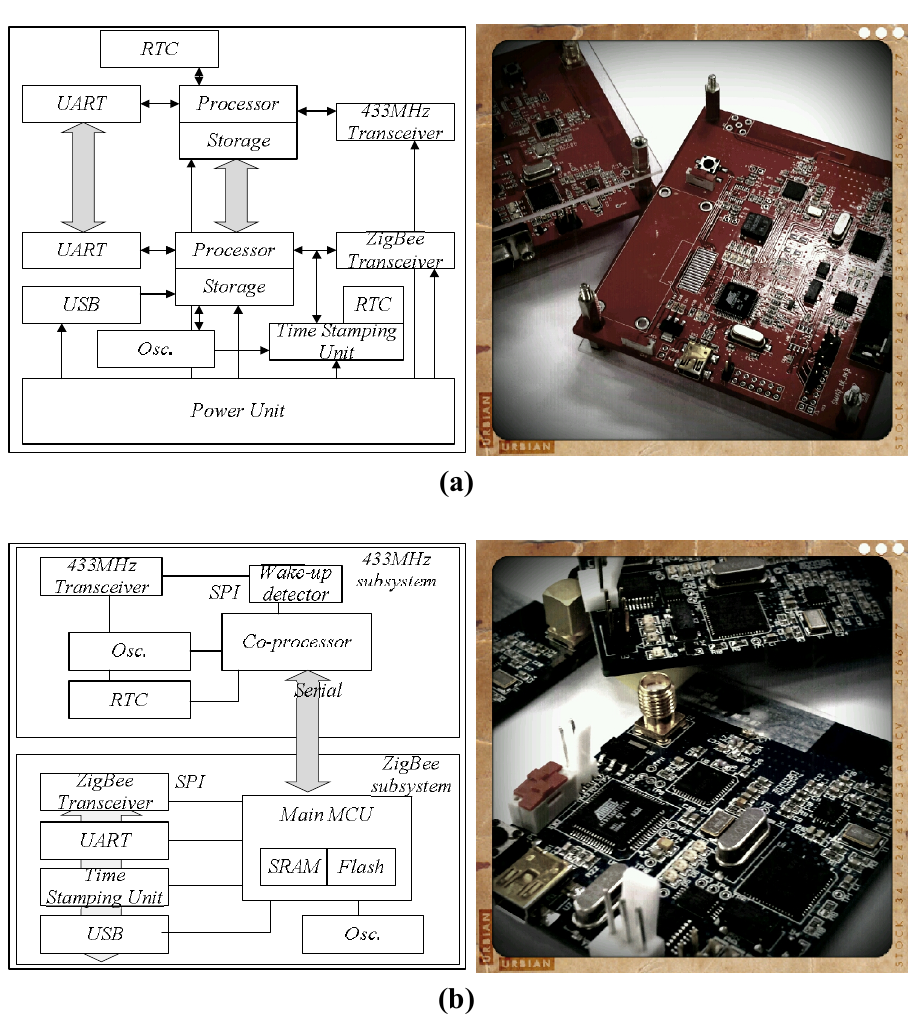
Figure 12. Sink node and sensor node. (a) sink node; (b) sensor node.